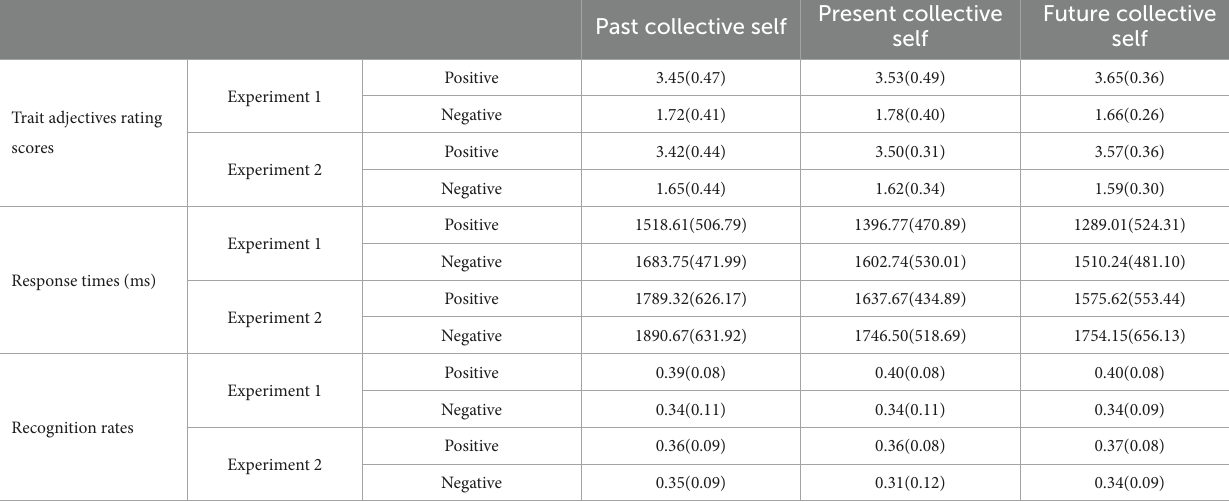
TABLE 1 Descriptive statistical results of trait adjectives rating scores, response times, and recognition rates ( M ±